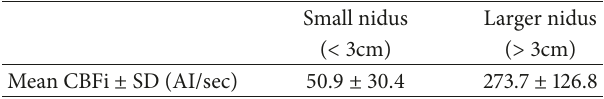
Table 3: Comparison of CBFi according to the size of